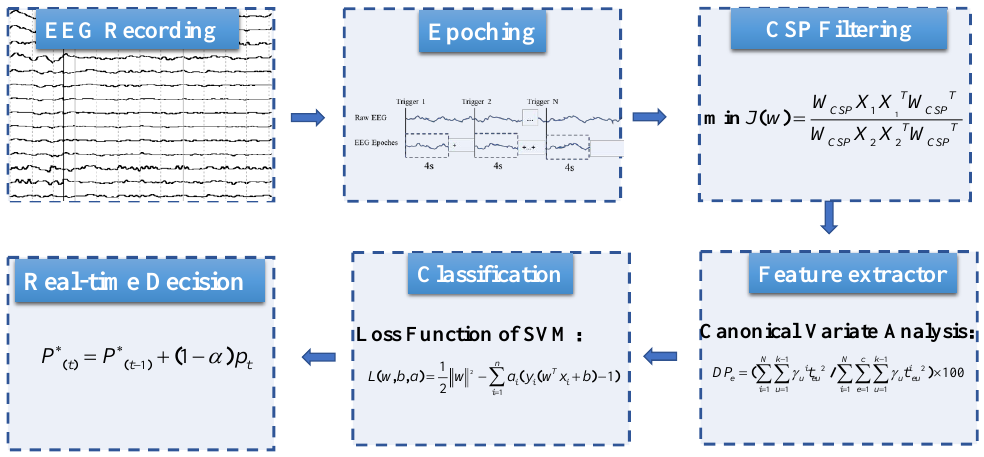
Figure 4. The architecture of the SVM-based framework for the